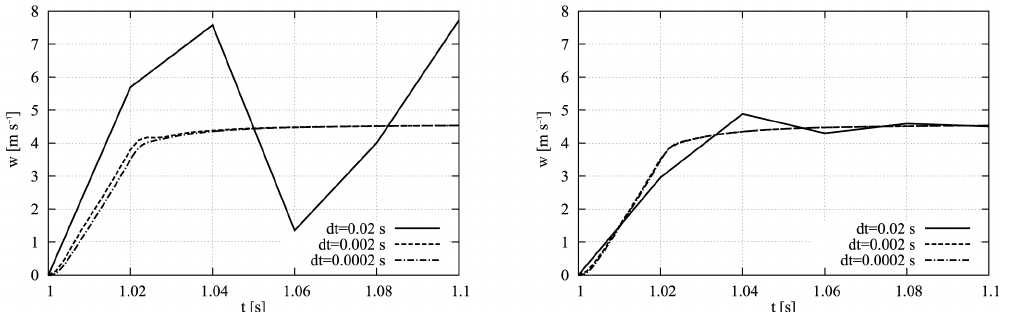
Figure 11. Buildup of the downwash for a horseshoe vortex depending on the time step. The NWM tends to be unstable (left) but can be stabilized by iterating to convergence of the downwash (right).